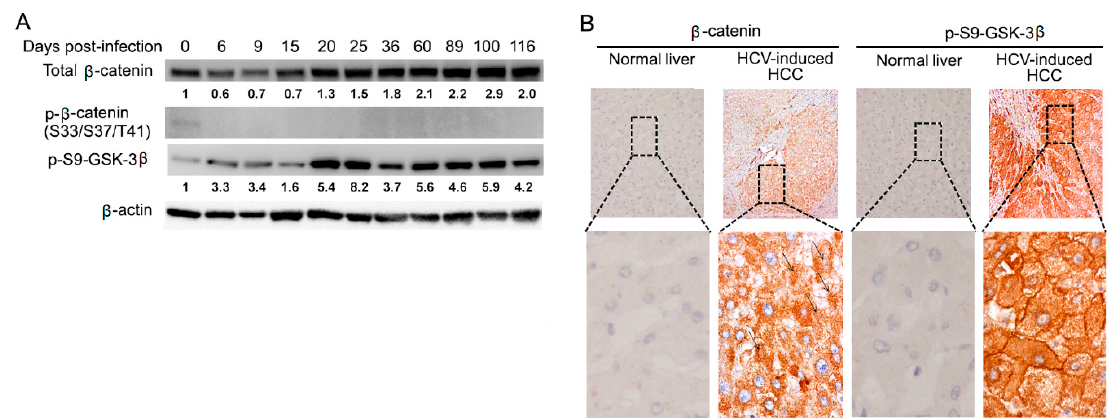
Figure 2. Wnt/ β -catenin signaling activation in chronic HC-infected cells and HCV-induced HCC patient tissues. ( A ) Cell lysates were taken at the indicated time points (d0, d6, d9, d15, d20, d25, d36, d60, d89, d100, and d116) after HCV infection and analyzed for total β -catenin, p- β -catenin (S33/S37/T41), and p-ser9-GSK-3 β by Western blotting. Quantification of the protein expression levels relative to the β -actin control was expressed as a ratio of the protein expression levels in the uninfected control cells as indicated under each lane. ( B ) Immunohistochemical staining was performed for β -catenin and p-Ser9-GSK-3 β in HCV-induced HCC patient